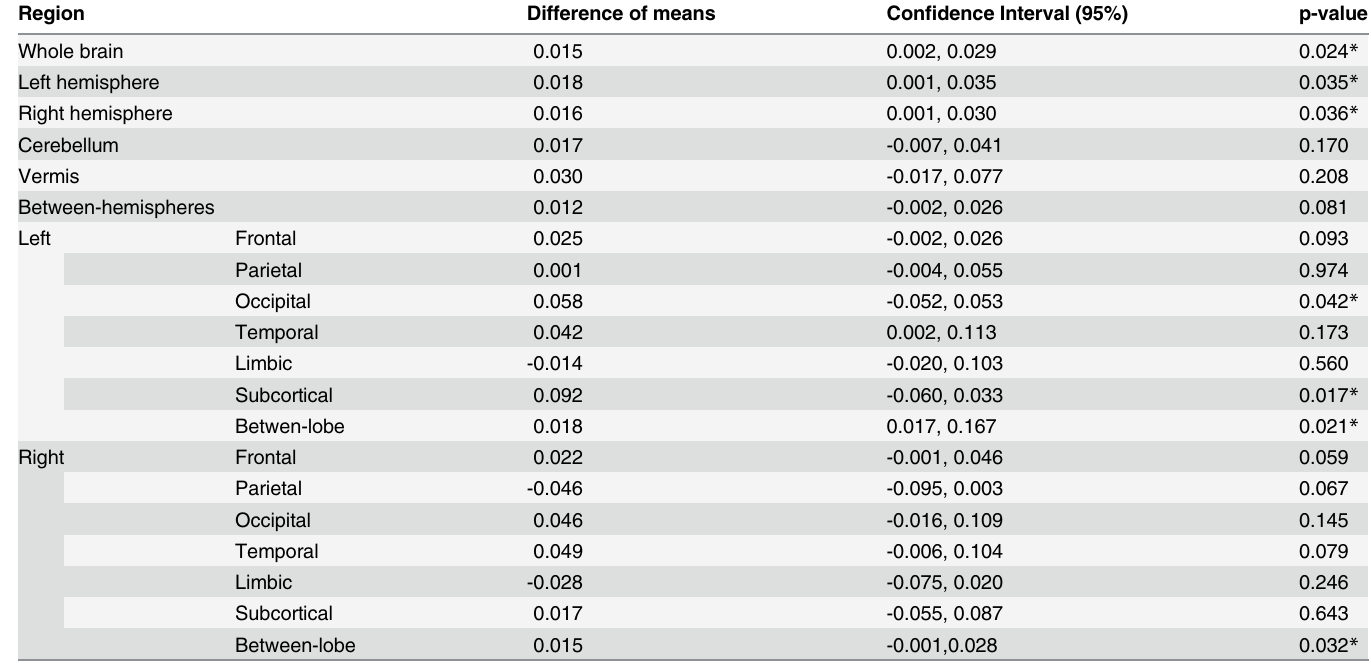
Table 3. Semi-metric percentages for ASC vs control groups.